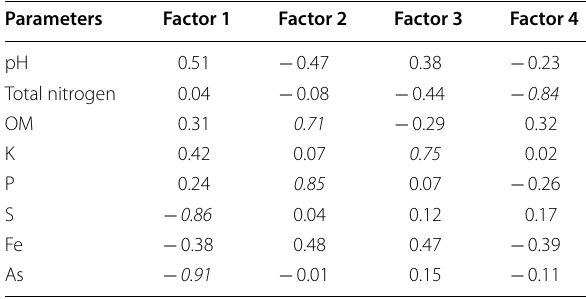
Italic values represent that level of significance among different parameters